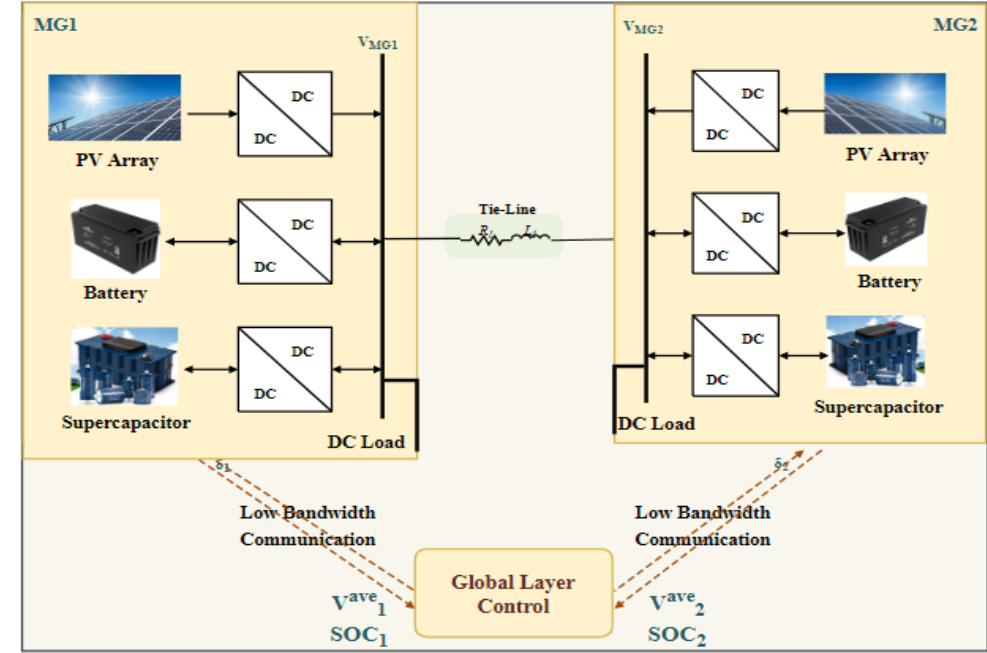
Figure 1. Interconnected DC microgrids configuration.